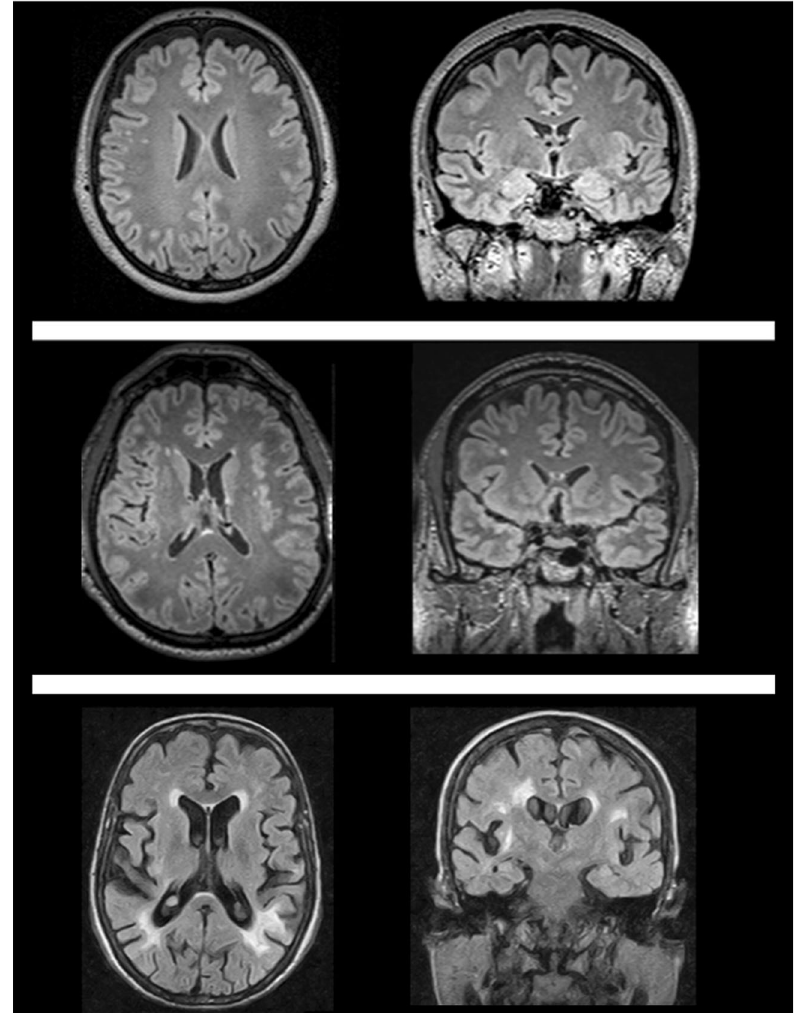
Fig. 2 White matter involvement in Fabry disease could range from small, scattered and punctuate T2- weighted hyperintense foci ( up- per row , 46-year-old woman, or middle row , 52-year-old man) to bilateral diffuse, patchy and partly confluent white matter hyperintensities ( lower row , 40- year-old woman). Although being the most common neuroimaging finding in Fabry disease, white matter hyperintensities appear- ance and distribution are not spe- cific in this